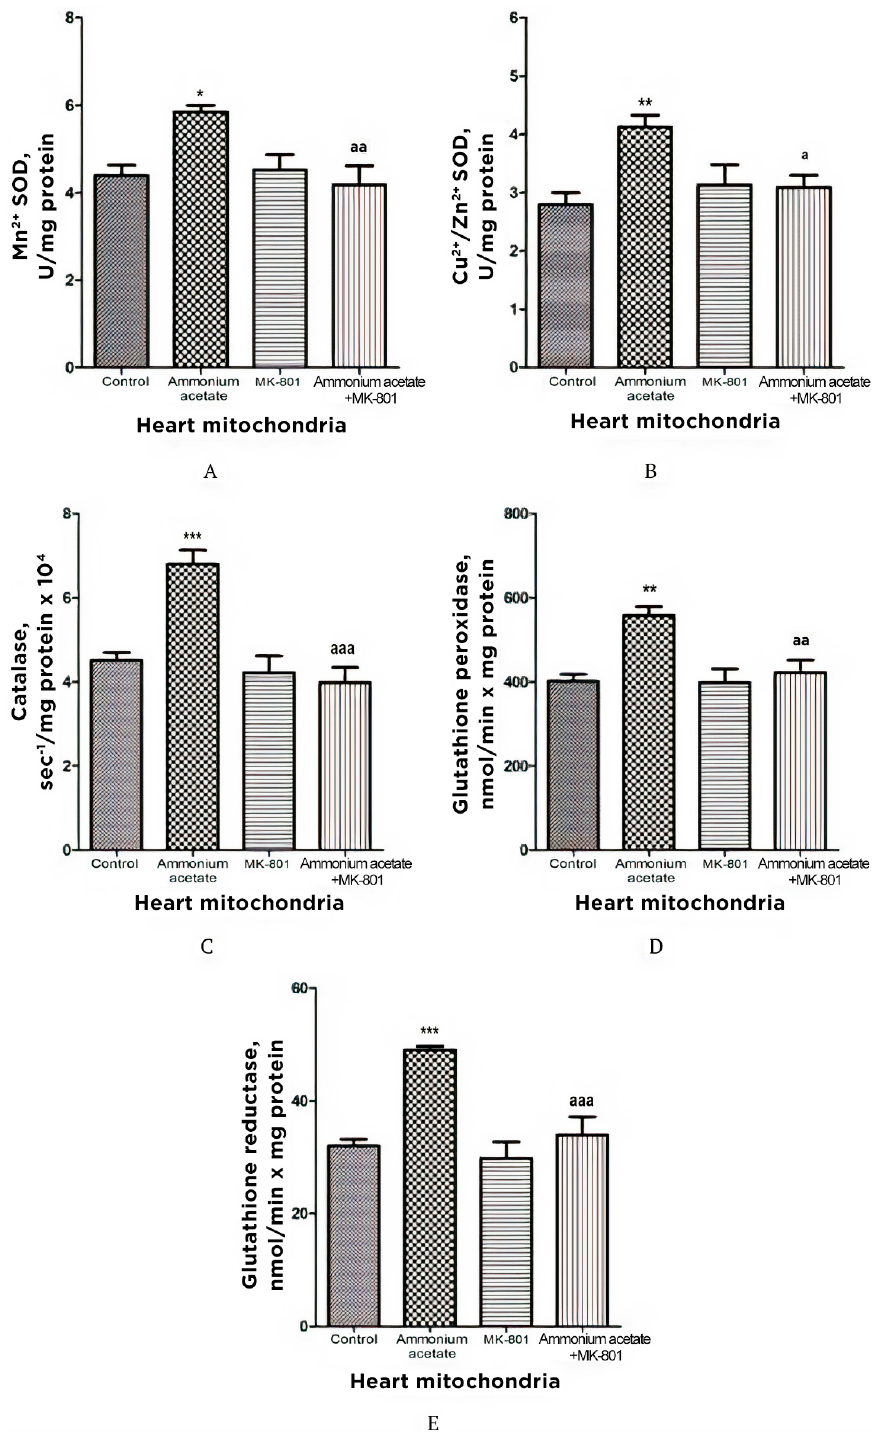
Figure 8. Effects of injection of ammonia and/or MK-801 on the activity of antioxidant enzymes superoxide dismutase (Mn 2+ ( A ) and Cu 2+ , Zn 2+ ( B ) isoforms), catalase ( C ), glutathione peroxidase ( D ), and glutathione reductase ( E ) in heart mitochondria. Experimental design was the same as in Figure 1 legend. Enzyme activities were determined as indicated in Materials and Methods. The results are represented as mean ± SEM. Values significantly different from the control group are indicated by one (*), two (**) and three (***) asterisks: * p < 0.05, ** p < 0.01, *** p < 0.001 (Student’s t -test). a significant differences, compared with the ammonia group. a p < 0.05, aa p < 0.01, aaa p < 0.001 (with the Bonferroni correction for multiple